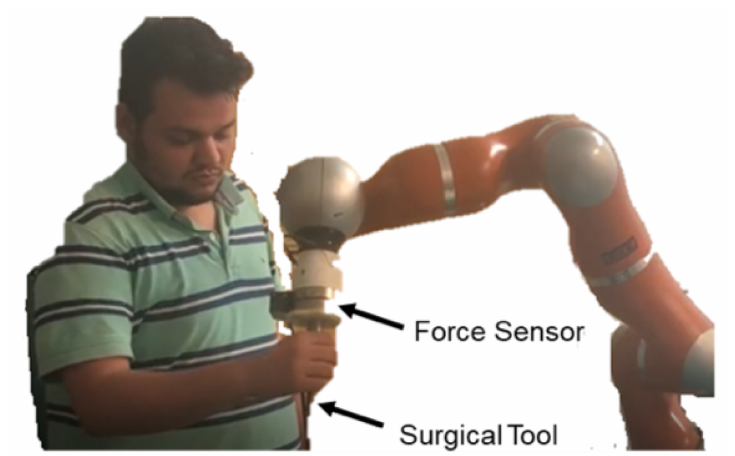
Figure 13. Hand-force applied on the tool of the robot.